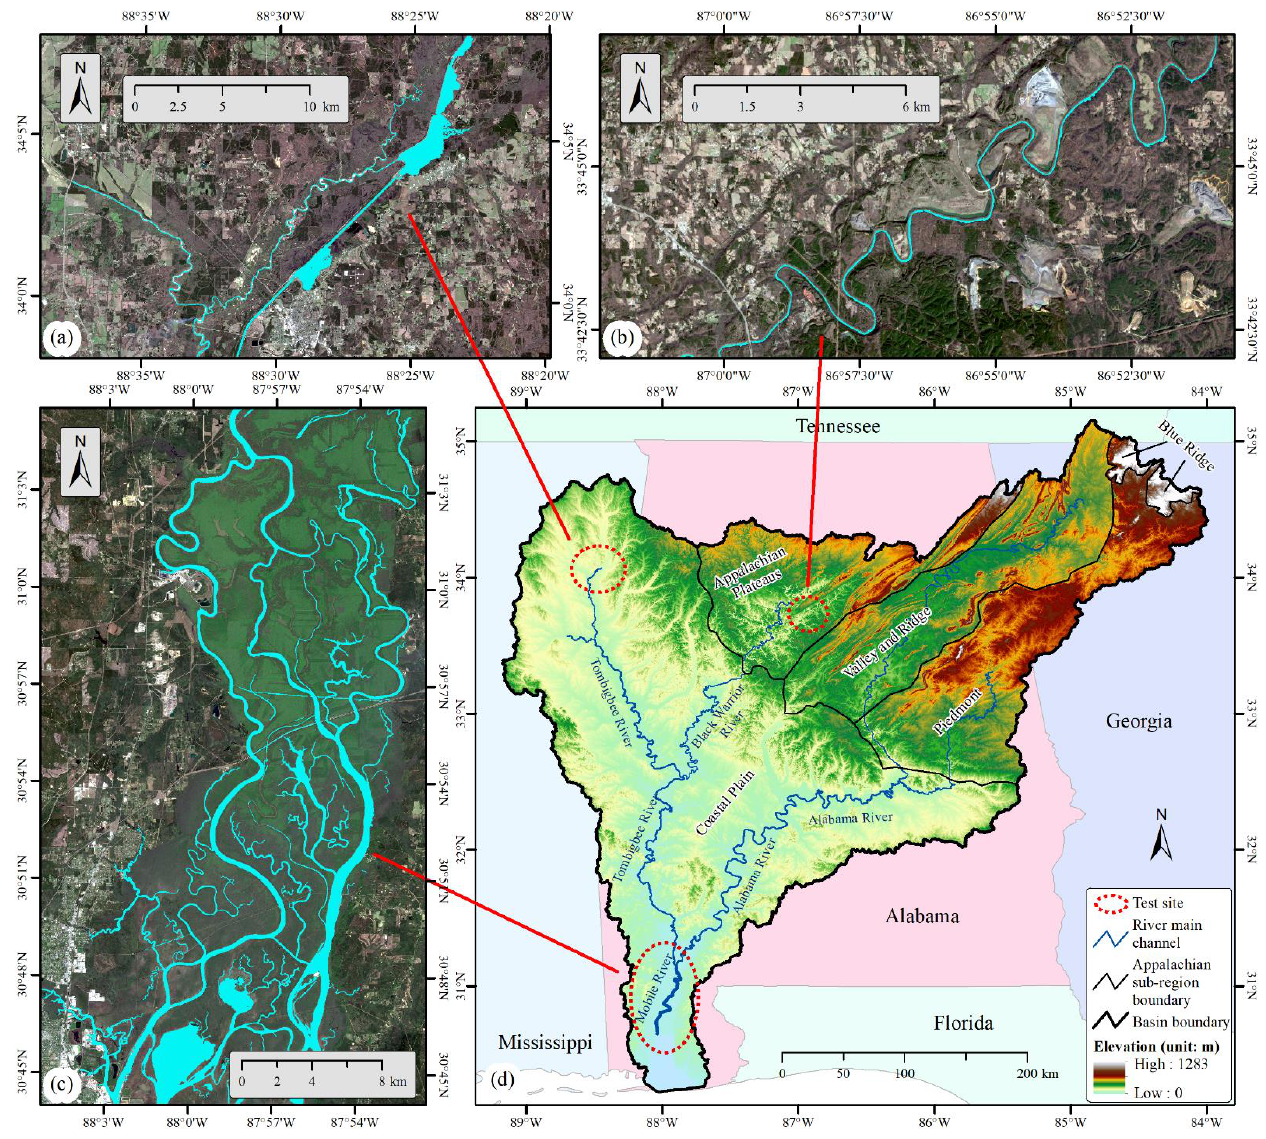
Figure 1. The geographic settings of the MRB ( d ) and inside lotic habitats: ( a ) parallel river channels and in-river reservoirs (3/19/2019); ( b ) meandering river channel (4/26/2019); and ( c ) braided river network (3/19/2019). Sentinel-2 image data are from ESA, DEM data are from USGS. Waterbodies are highlighted in sapphirine.